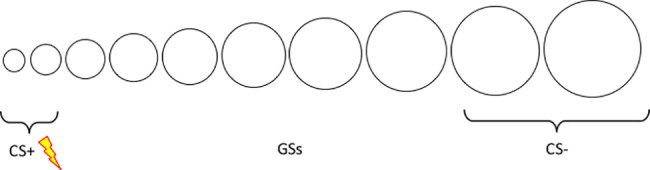
Stimulus set one.